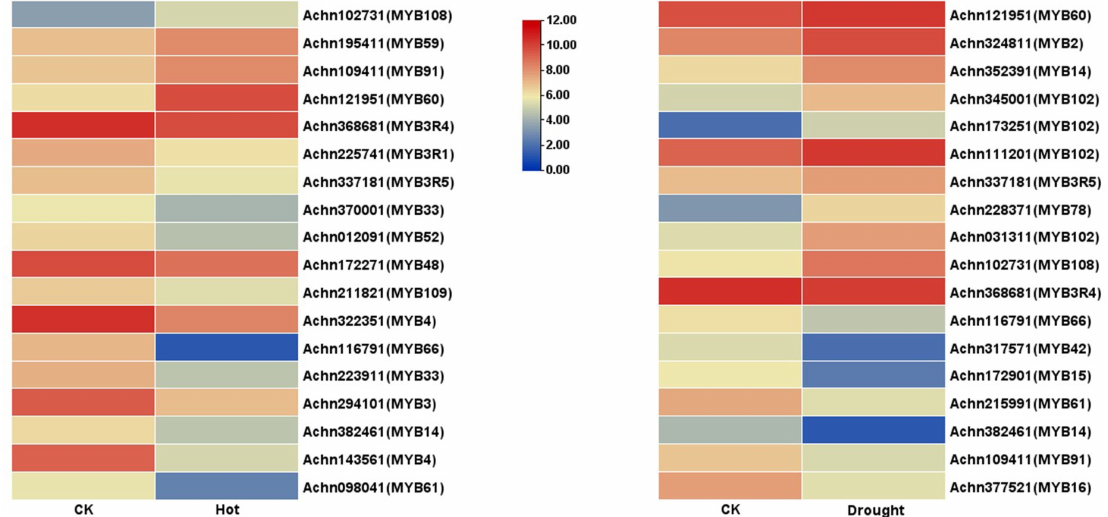
Figure 5. Heatmap of AcR2R3-MYB TFs’ transcriptional profiles in kiwifruit under drought and high-temperature